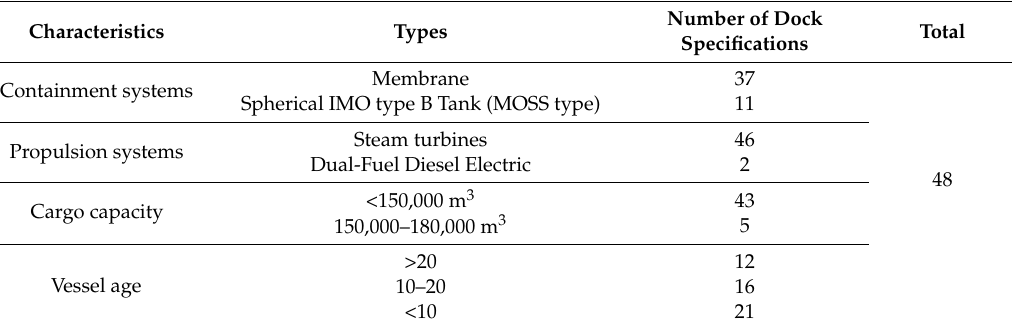
Table 1. Information collected on dock specifications based on characteristics of liquefied natural gas carriers